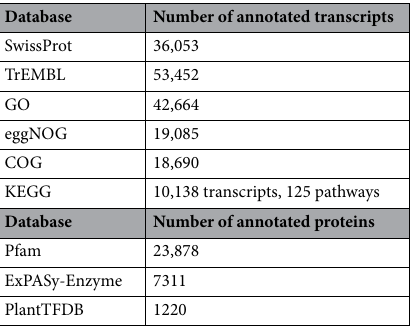
Table 2. Summary of the annotation output for the D. cymosum transcriptome.